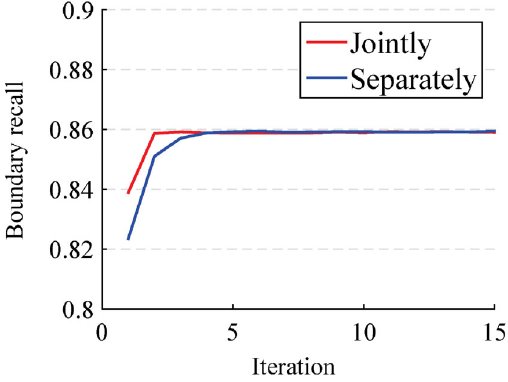
Fig. 10 Comparison of convergence rate for joint and separate assignment and update